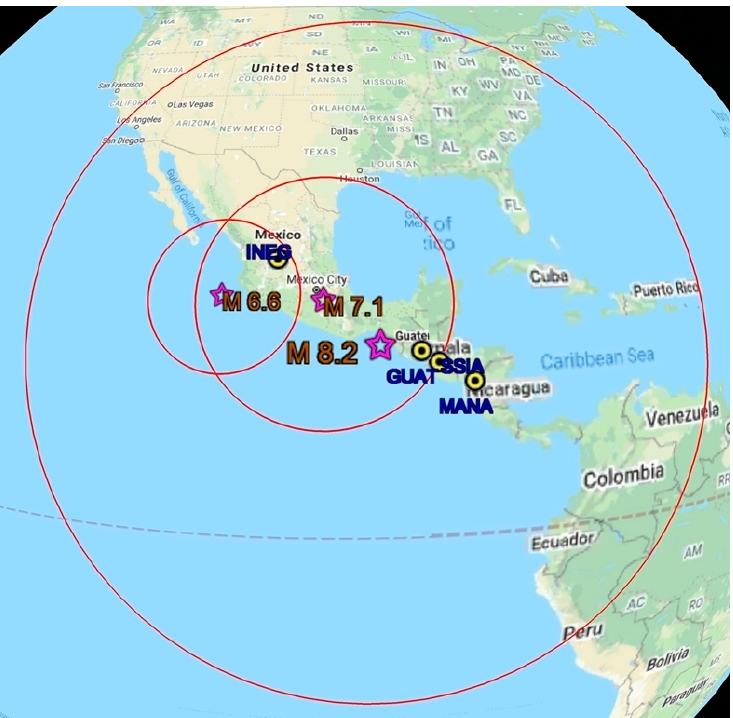
Figure 1. Map showing preparation zones (red circles), epicenters (purple asterisks) and IGS receivers (yellow dots) used for the three large earthquakes in Mexico during 2016 and 2017.